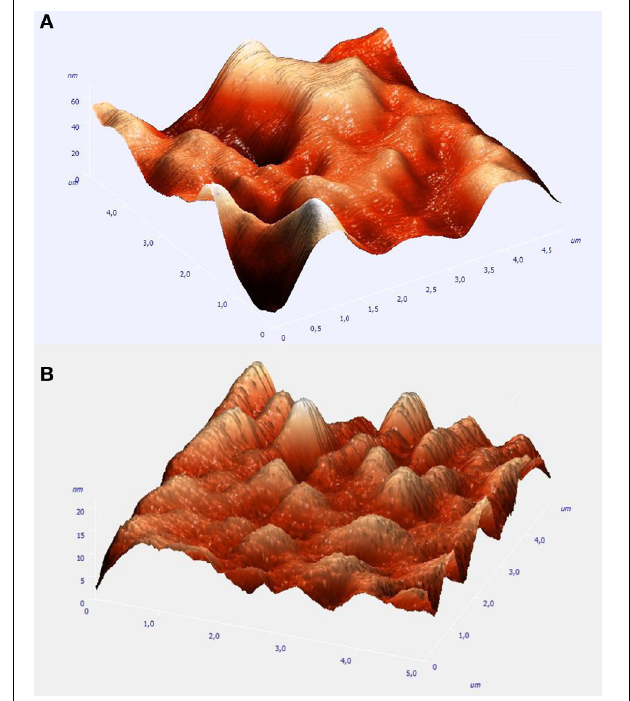
FIGURE 2 | AFM micrographs of 5 × 5 µ m sample areas of: (A) the Pt(Ni) coating of Figure 1A above; (B) the Pt-Ru(Ni) coating of Figure 1B